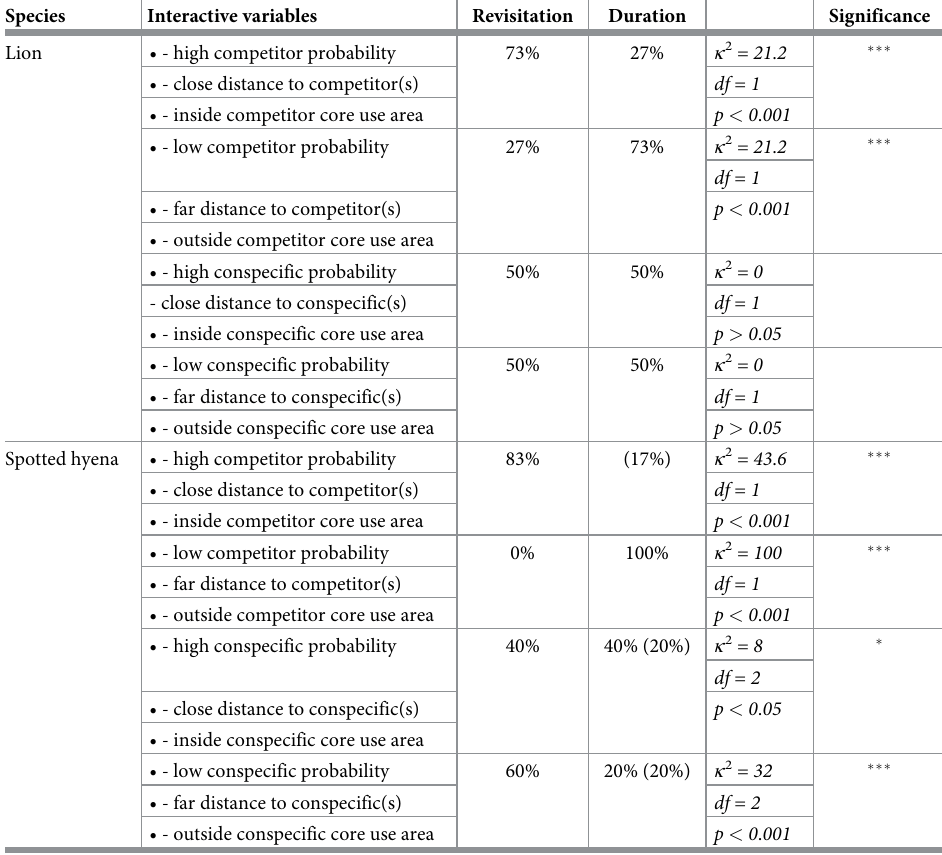
Percent frequency occurrence of revisitation (nsv, number of separate visits) and extended duration (mnlv, mean number of locations per visit) obtained from the k -prototype clustering of social interactive covariates in the RD space of each individual. Significance from chi-square analyses is denoted with an asterisk at the alpha level of 0.05, and with a triple asterisk at 0.001. Numbers in brackets indicate short